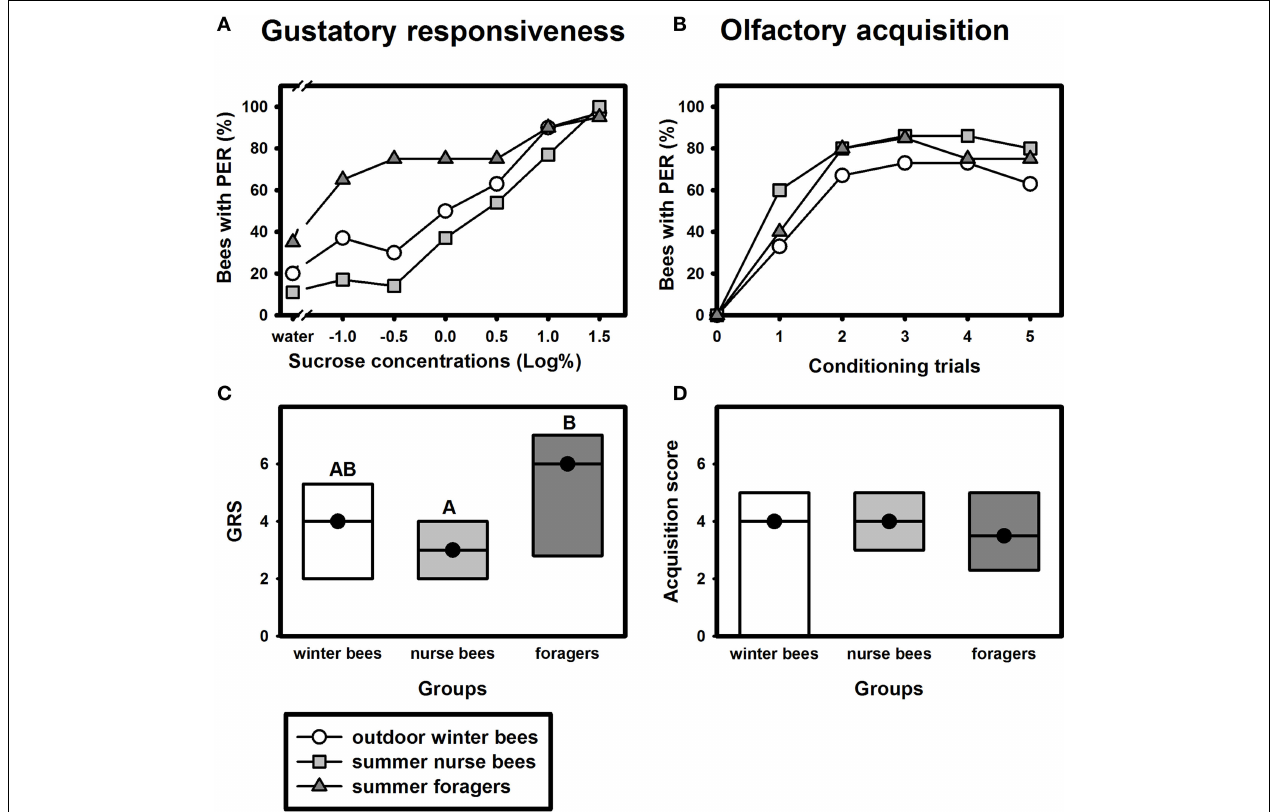
FIGURE 1 | Gustatory responsiveness and olfactory acquisition of outdoor winter bees, summer nurse bees and summer foragers. (A) Sucrose- concentration response curves of outdoor winter bees, summers nurse bees and summer foragers. The x -axis displays the sucrose concentration offered to the antennae of each bee. The y -axis shows the percentage of bees showing the proboscis extension response (PER). (B) Olfactory acquisition curves of outdoor winter bees, summer nurse bees and summer foragers. The x -axis displays the conditioning trials. The y -axis shows the percentage of bees showing conditioned